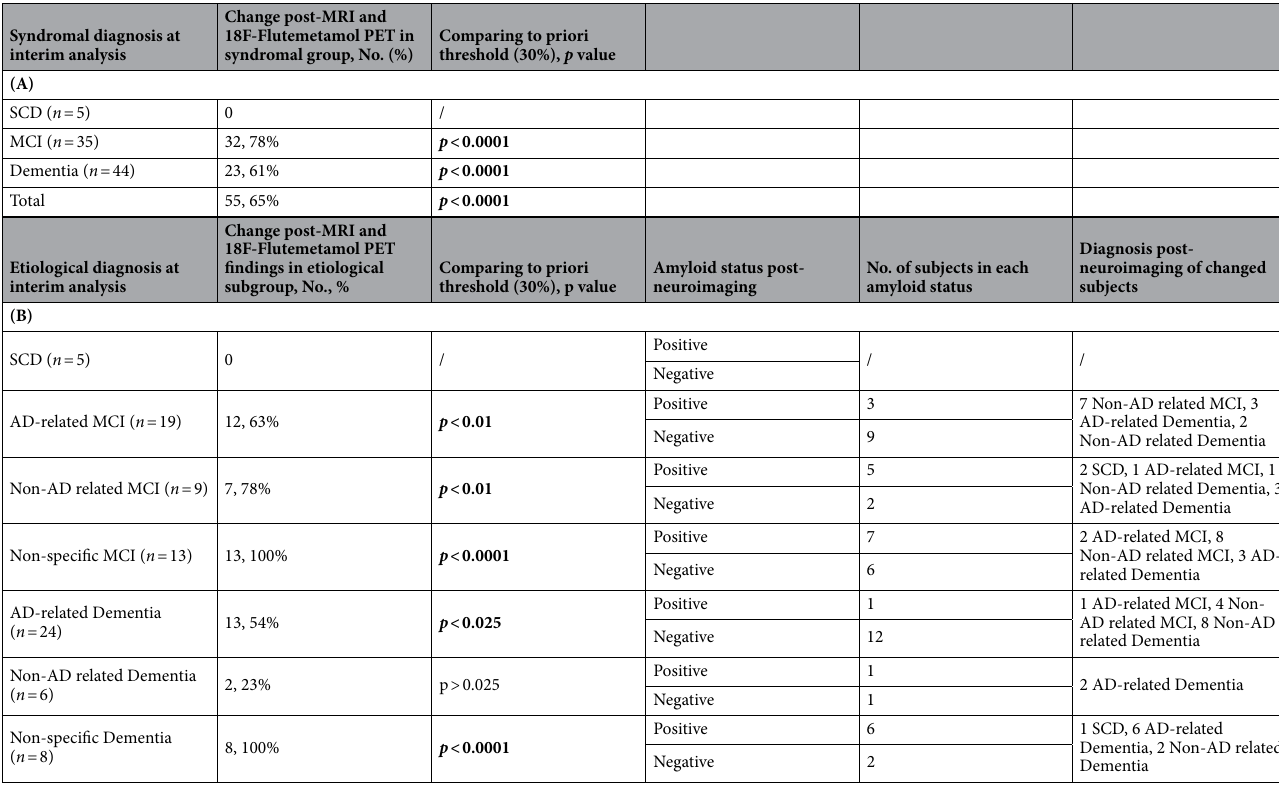
Table 7. Change in diagnosis following MRI and 18F-Flutemetamol PET. Significant values are in [bold]. (A) in the syndromal group, (B) in the etiological subgroup.